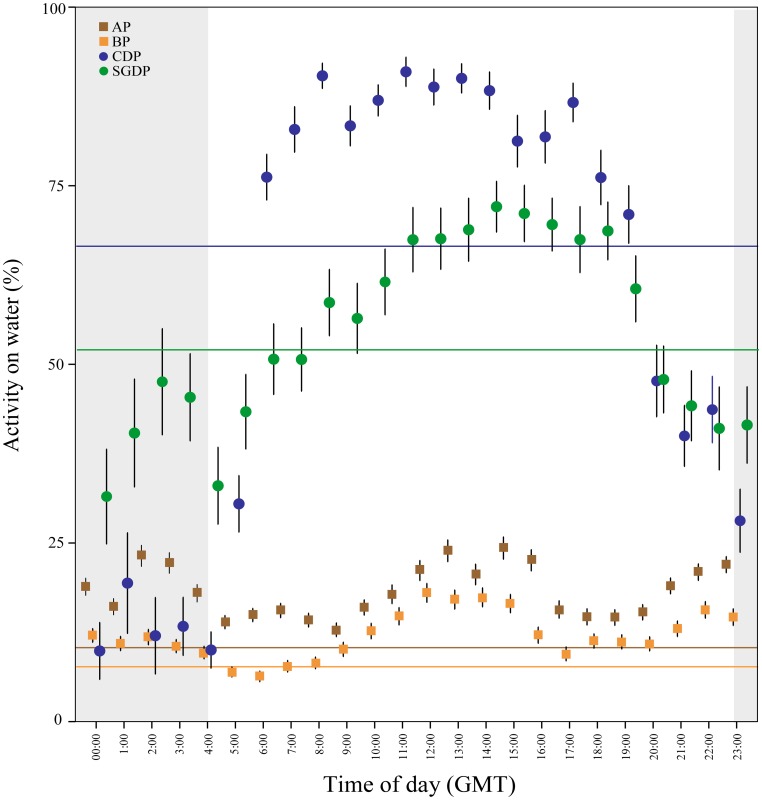
At-sea activity patterns.Mean daily percentage of time spent on water ± SE of 12 Antarctic prions (AP), 12 blue petrels (BP), 9 common diving petrels (CDP), and 8 South Georgian diving petrels (SGDP) tracked using immersion loggers during incubation at Bird Island, South Georgia in summer 2010/11. Shaded areas indicate darkness. The mean value of waveform for each species is indicated with a horizontal line (different colour for each species).